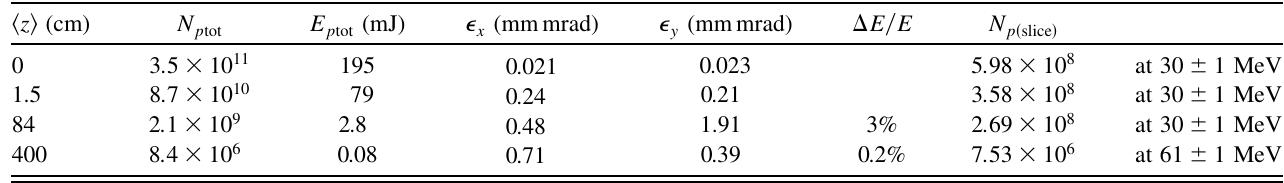
TABLE I. Bunch parameters for the composite target (TNSA) at different stages. The values quoted in the columns for N E refer to the whole proton bunch, with E > 1 MeV for z > 0 . The values quoted in the columns (cid:8) p tot energy slice defined in the last column. The laser energy is 6.75 J. The energy spread (cid:1) E for a distribution peaked at E is defined by dN=dE ð E (cid:6) (cid:1) E Þ ¼ e (cid:1) 1 dN=dE ð E Þ